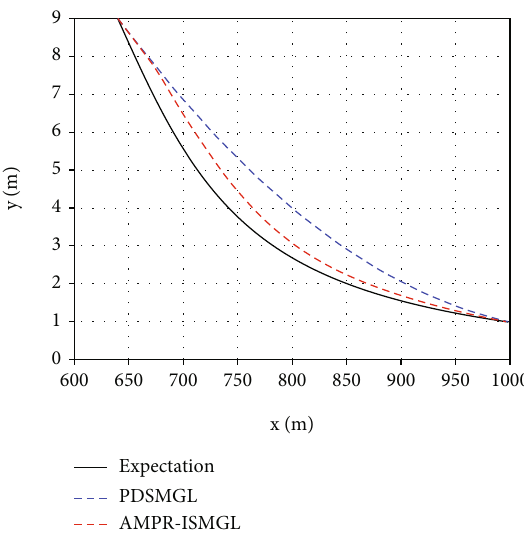
Figure 9: Trajectory comparison and trajectory inclination